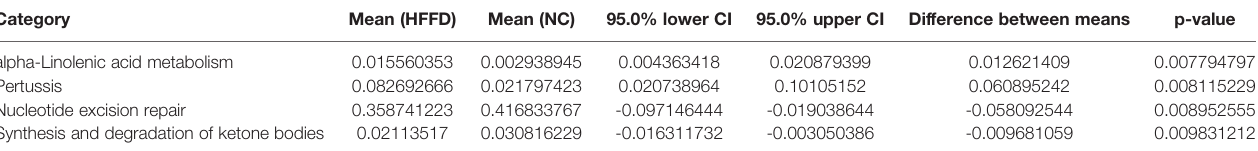
TABLE 6 | PICRUSt predicted results of HFFD v.s HFFD-Y.